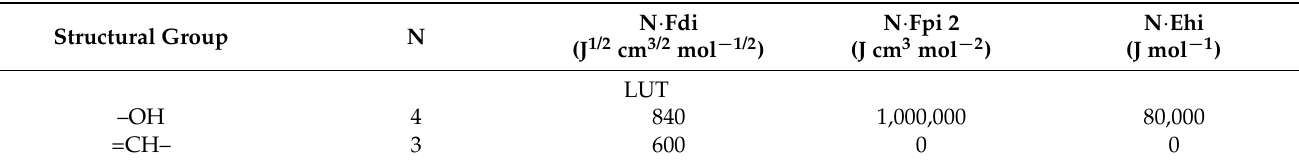
Table 1. Estimation of HSPs for LUT and PVP based on the Hoftyzer–Van Krevelen group contribu- tion